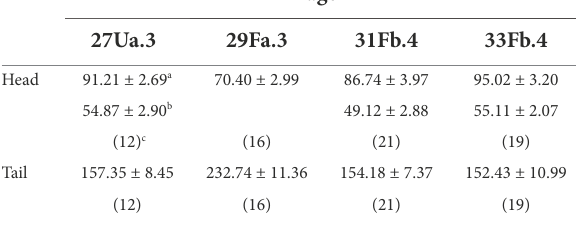
TABLE 4 Phage measurements from EM